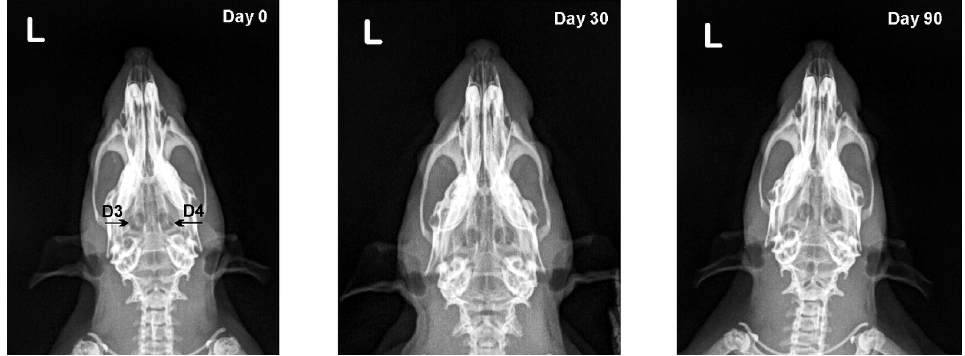
Figure 3. Serial dorsoventral radiographs of calvarial bones of rats from the second experimental group after collagen cone and i.p. EPO injection (D3) and empty defect and i.p. EPO injection (D4) on post-operative days 0, 30 and 90.